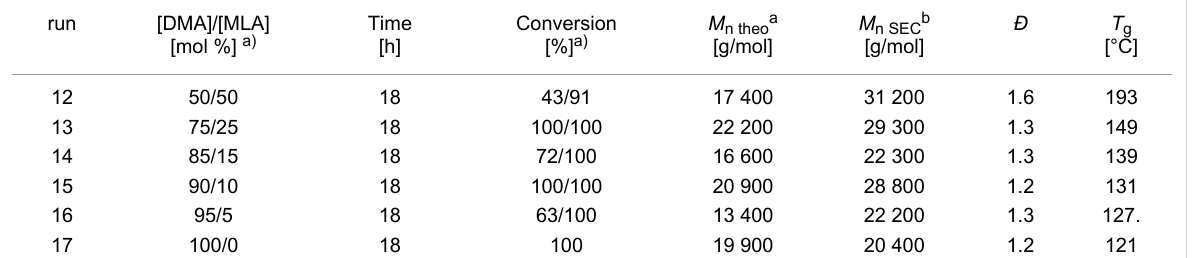
Table 5: RAFT copolymerization of MLA with DMA (0.5 mol % EMP and 0.0625 mol % AIBN, 80 wt % 1,4-dioxane, 70 °C).